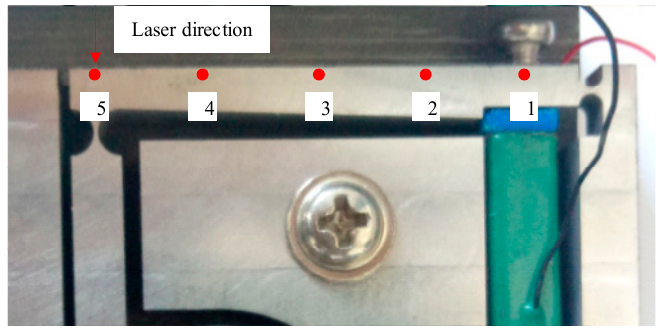
Figure 14. The beam AB free vibration test.